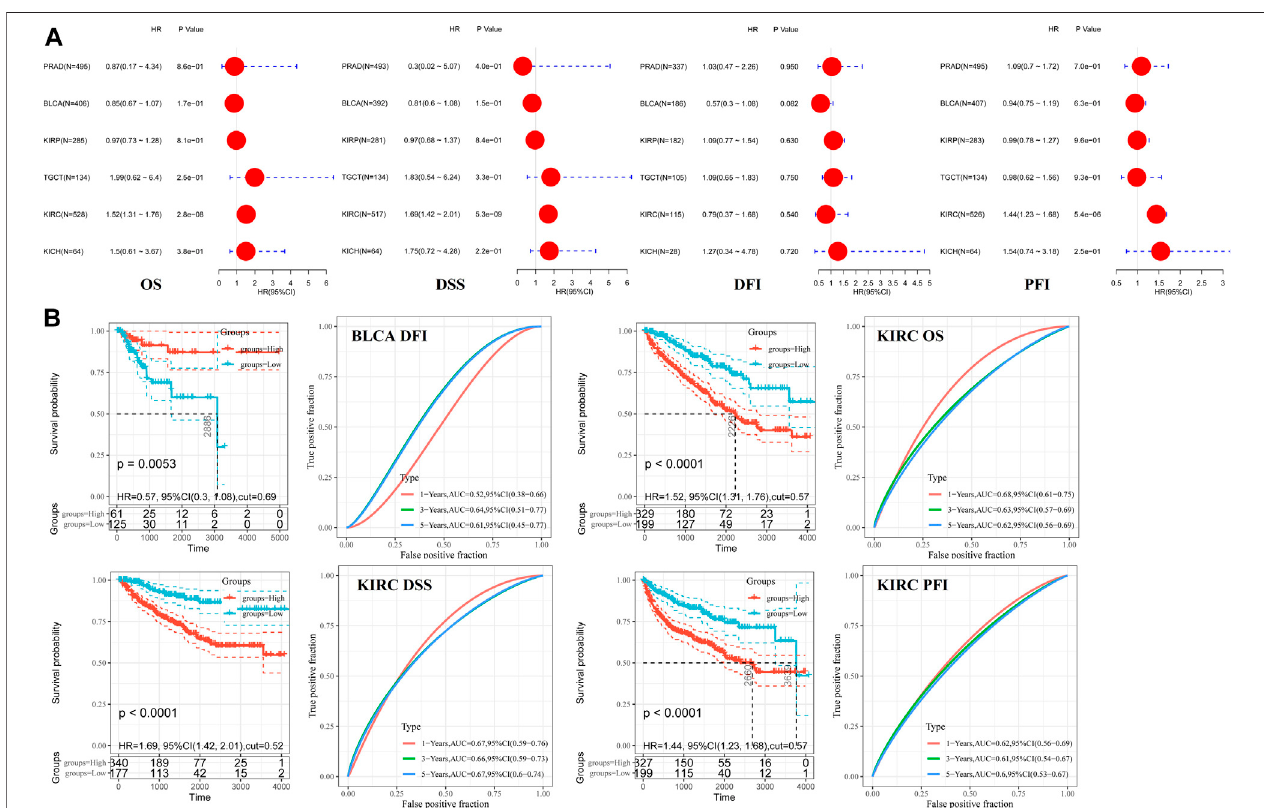
FIGURE 2 | Correlations between hepcidin levels and prognostic survival markers of male genitourinary system tumors. (A) Overall survival (OS) and disease-free survival (DFS) related to hepcidin levels in TCGA project as analyzed by GEPIA2. (B) Pooled analysis between hepcidin expression and OS, disease-free interval (DFI), disease-speci fi c survival (DSS), and progression-free interval (PFI) were conducted across male genitourinary system tumors using data from TCGA. (C) Receiver- operator characteristic curve (ROC) analysis was performed to determine the prediction ef fi ciency of hepcidin for the 1-, 3-, and 5-year OS, DFI, PFI, and DSS of patients with male genitourinary system